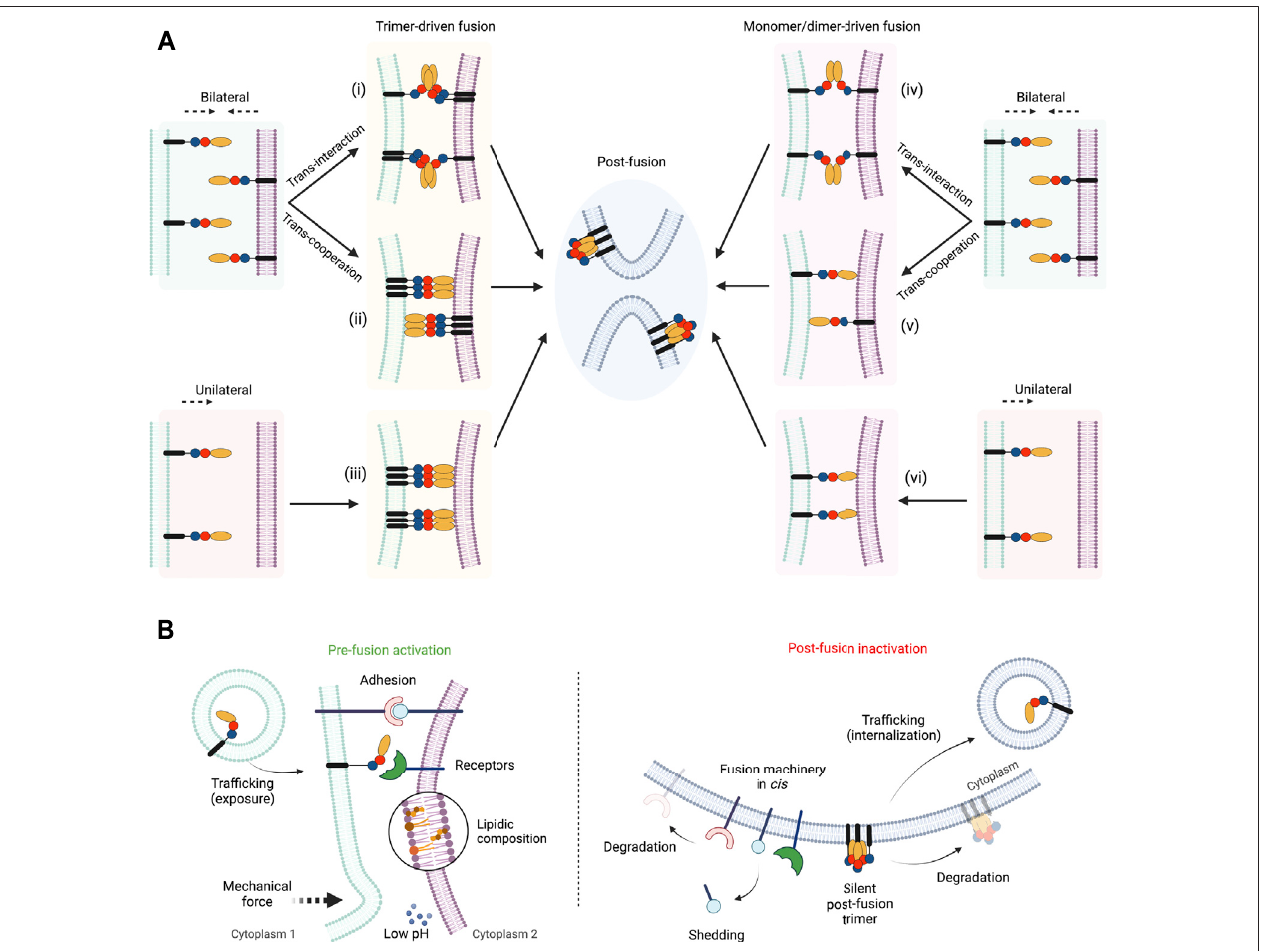
FIGURE 2 | Pathways and regulations of fusexin-mediated fusion. (A) Different models for the mechanism of action of fusexins. Fusion can be induced from both merging membranes ( “ bilateral, ” i, ii, iv and v) or from one of them ( “ unilateral, ” iii and vi). Within the bilateral mechanism, fusexins may interact forming dimers or trimers leadingtofusion( “ trans-interaction, ” reminiscentoftrans-SNAREs,iandiv)orcooperatebybindingtotheopposedmembrane( “ trans-cooperation, ” iiandv).Depending ontheintermediatestatesthatmediatemembranemergingthemechanismscanbedividedintotrimer-drivenfusion(i,iiandiii)ormonomer/dimer-drivenfusion(iv, v and vi). Independently of the mechanism, the post-fusion conformation is hairpin-shaped trimers. (B) Known mechanisms of pre-fusion activation (left panel) or post- fusion inactivation (right panel) of fusexins described in this review. Created with BioRender.com.